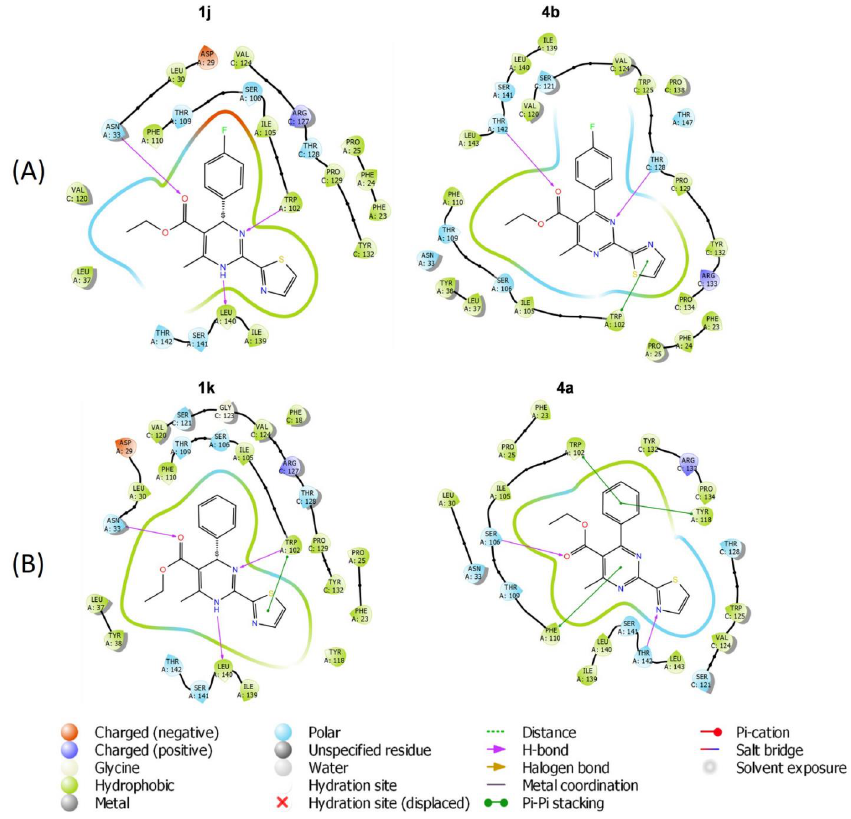
Figure 12. Interaction diagram of HAP compounds docked to HBc dimer interface. ( A ) Compounds 1j and 4b . ( B ) Compounds 1k and 4a .